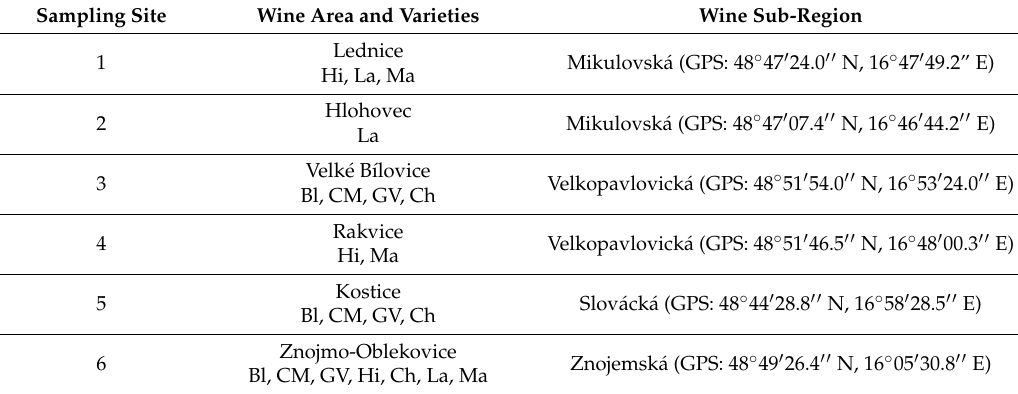
Table 1. Sampling sites of grape canes.